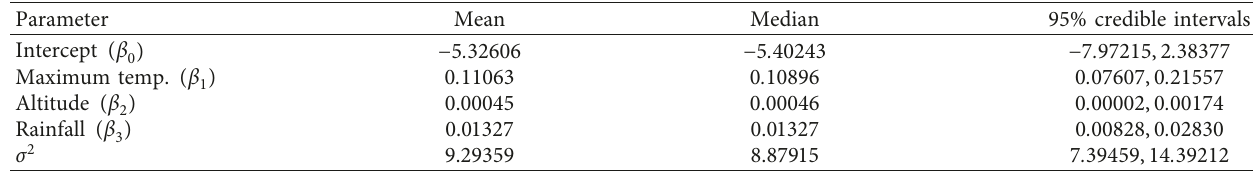
Table 4: Credible intervals of the intercept and covariates of the selected